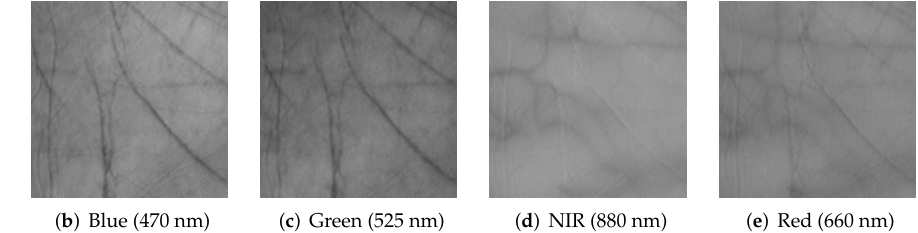
Figure 2. Example of PolyU multispectral palmprint dataset: ( a ) is a whole palm example, ( b – e ) are the region of interest (ROI) figures in different